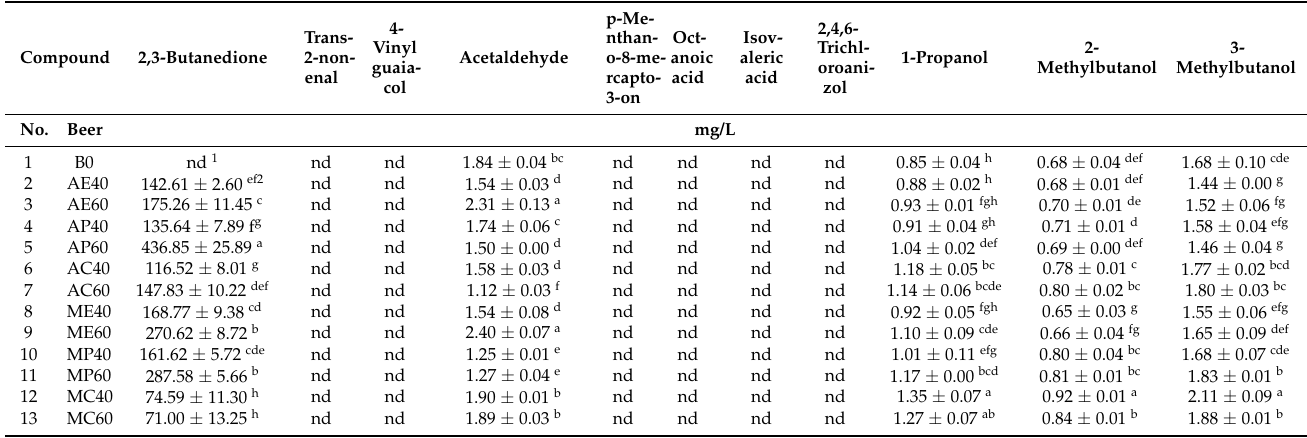
Table 4. Volatile compounds indicative of beer faults.